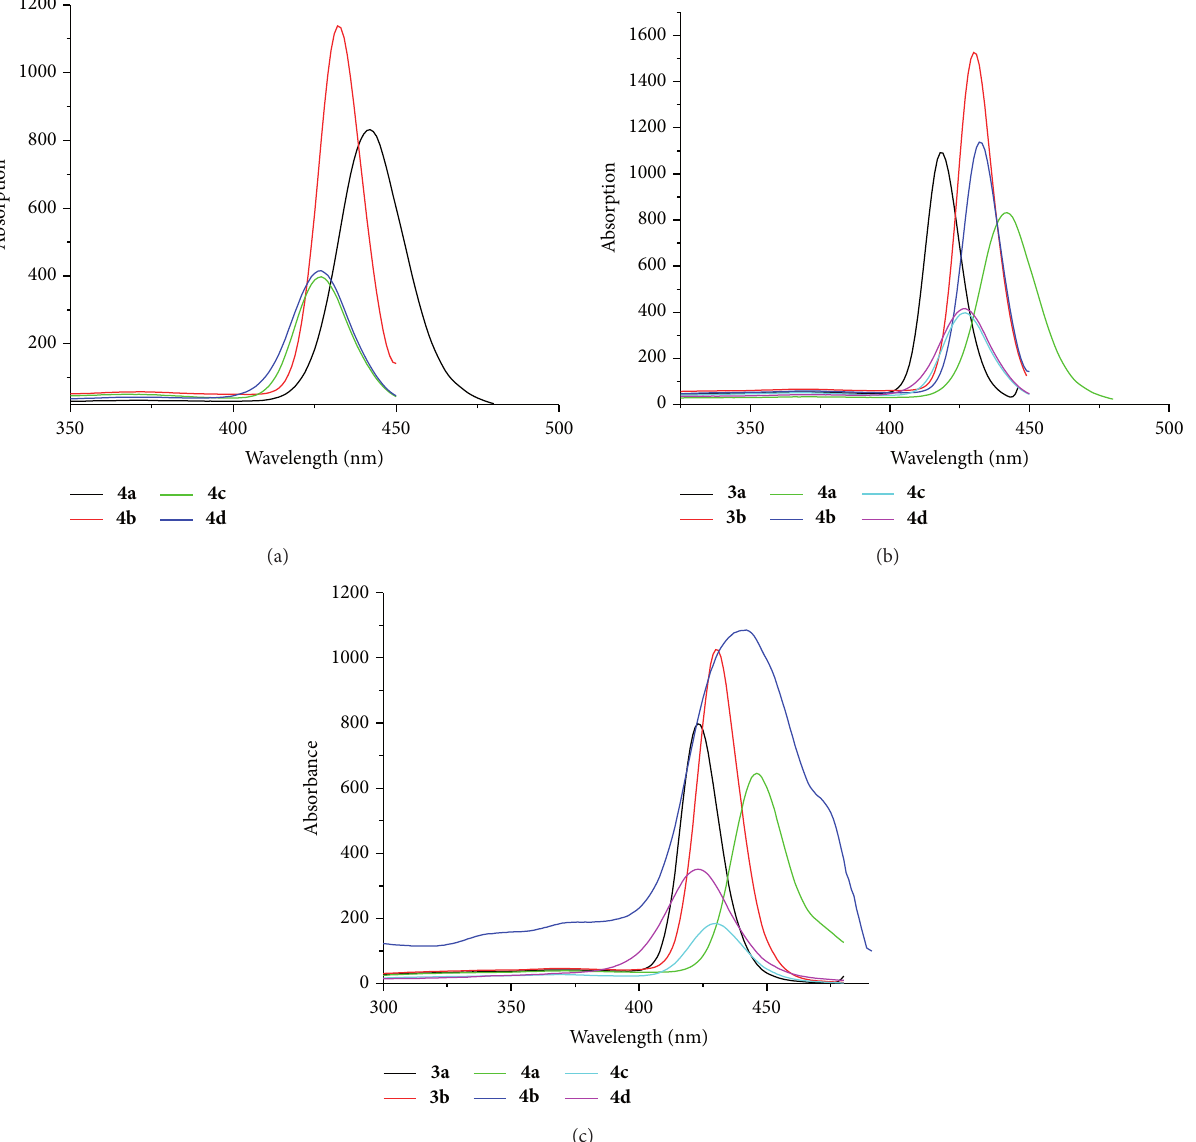
molecules. Typically, the �uorophore has a larger